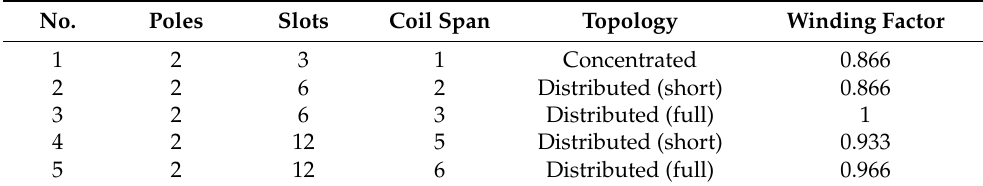
Table 2. Pole–slot combinations according to winding topology.